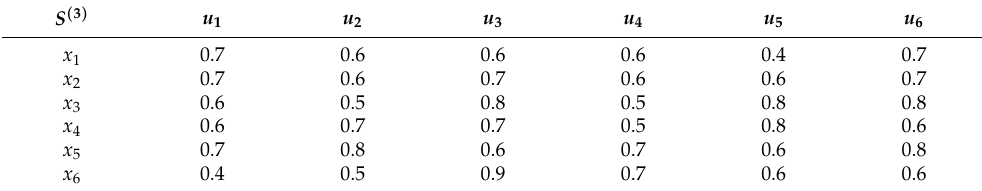
Table 5. Appraisal of expert e 3 .